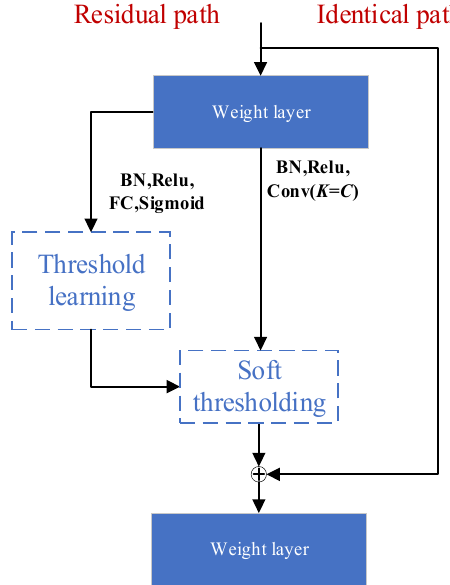
Figure 3. Basic structure of deep residual shrinkage network.